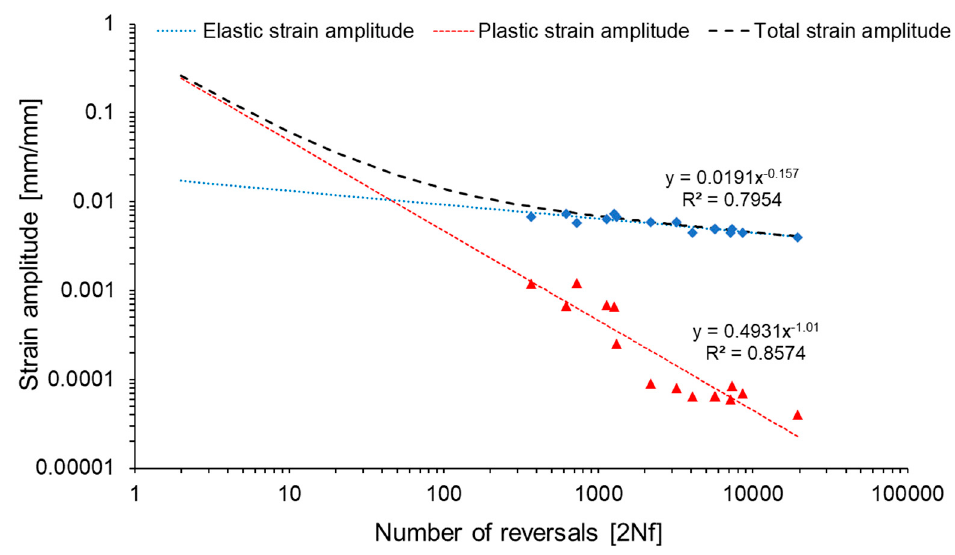
Figure 8. Number of half-cycle reversals vs strain amplitude in log–log coordinates.